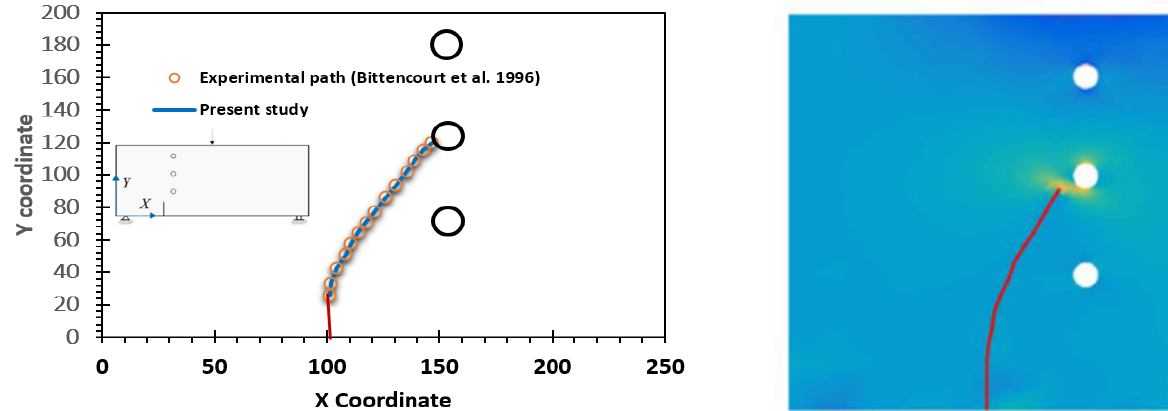
Figure 10. Ansys and experimental crack trajectory for the crack tip coordinate of specimen 3 ( left ) and numerical results